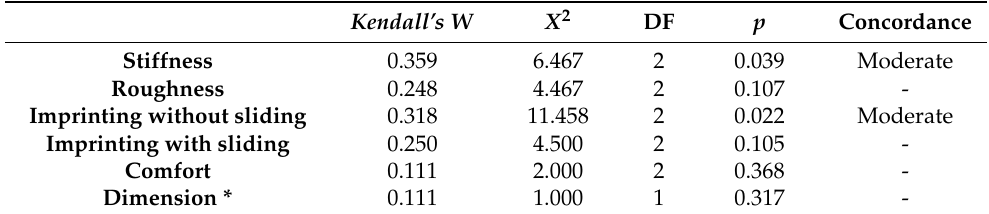
Table 4. Evaluation of the significance of the degree of concordance of the evaluation of the sensor prototypes (n = 9). Coimbra, Portugal, 2022. Kendall’s